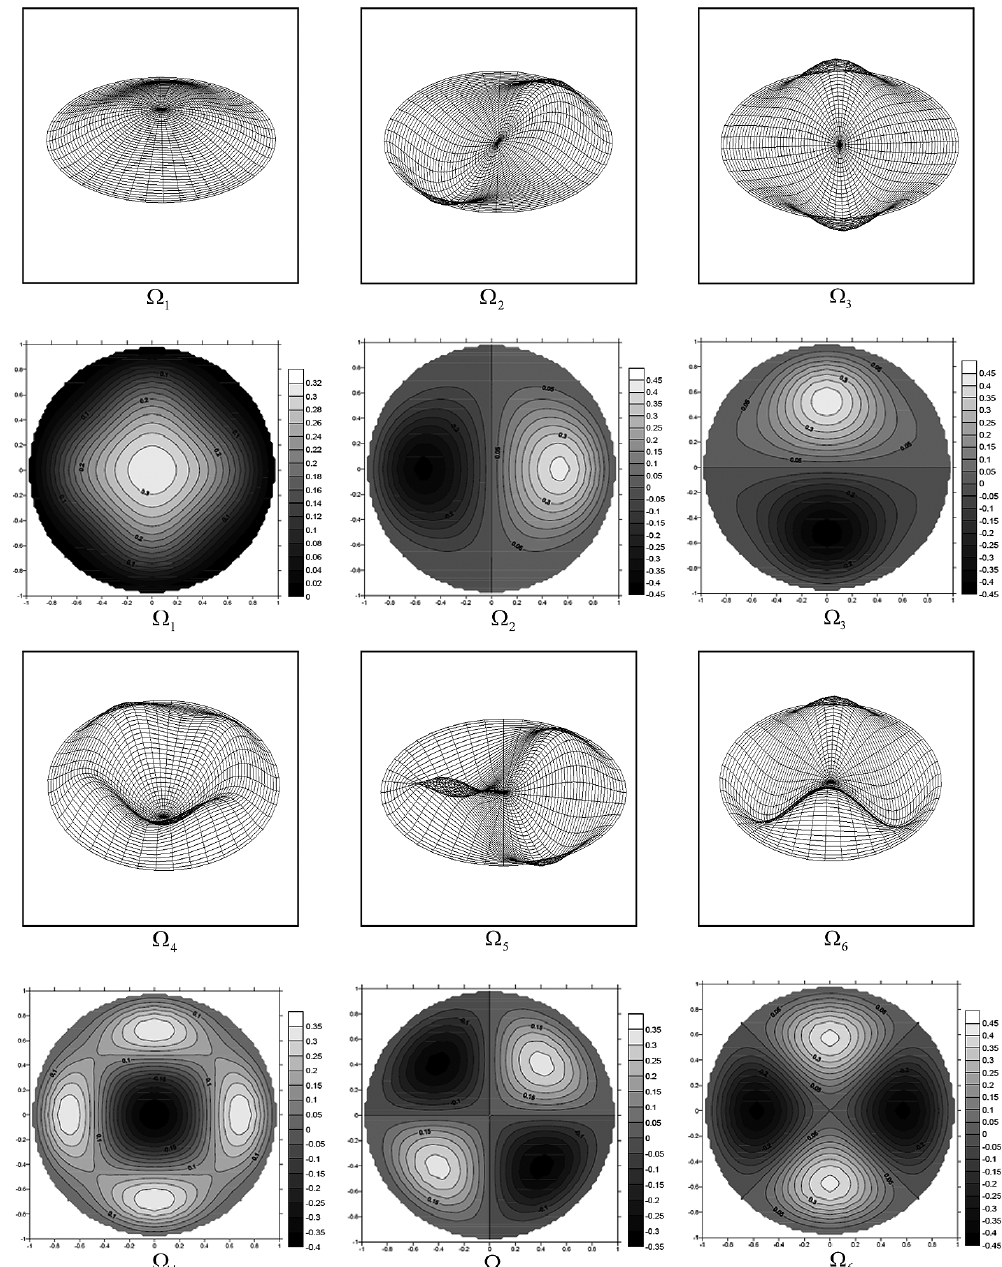
Fig. 8. First six normal modes and their contours for C-plates when α = β = 0.5 and k =